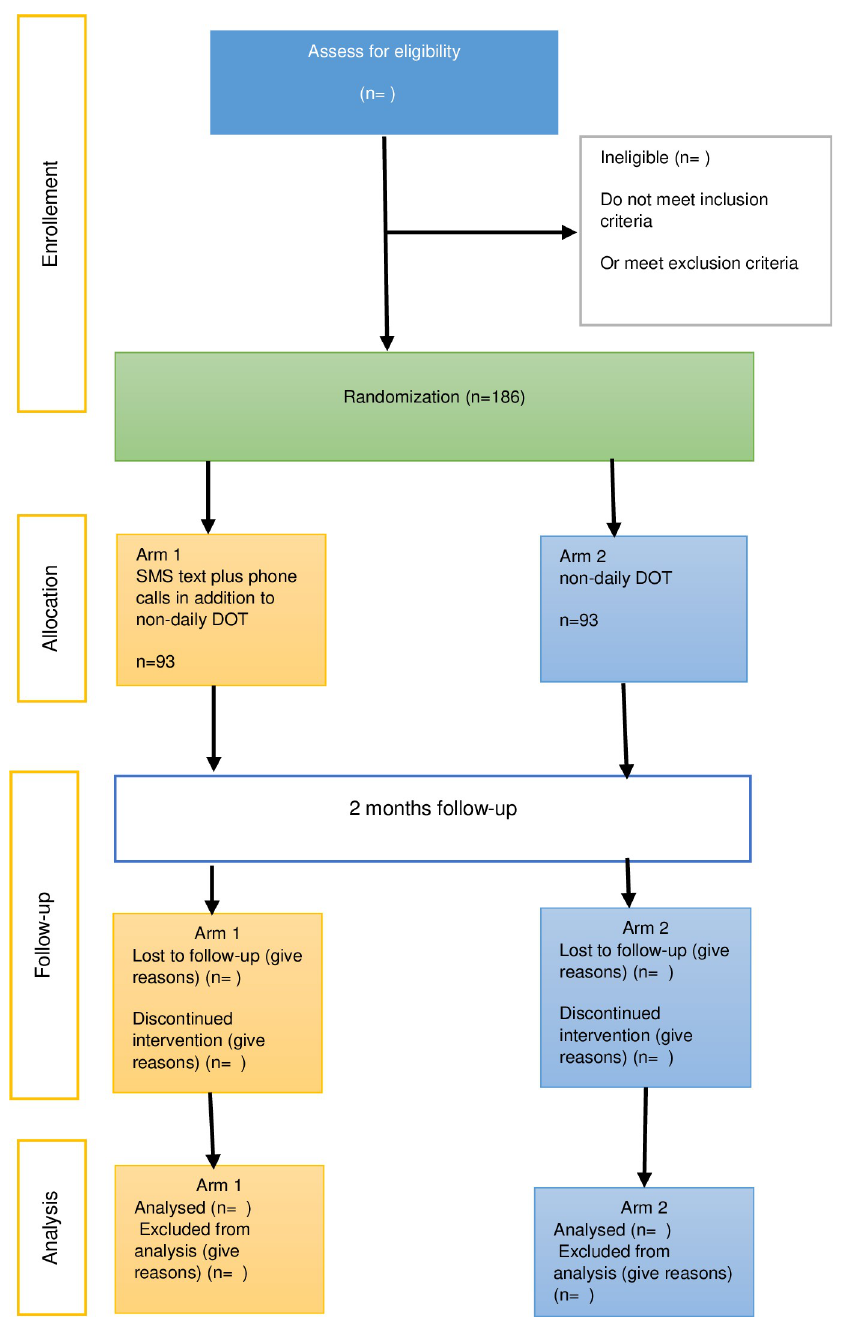
Fig 4. Flow diagram for Ma-MAS intervention